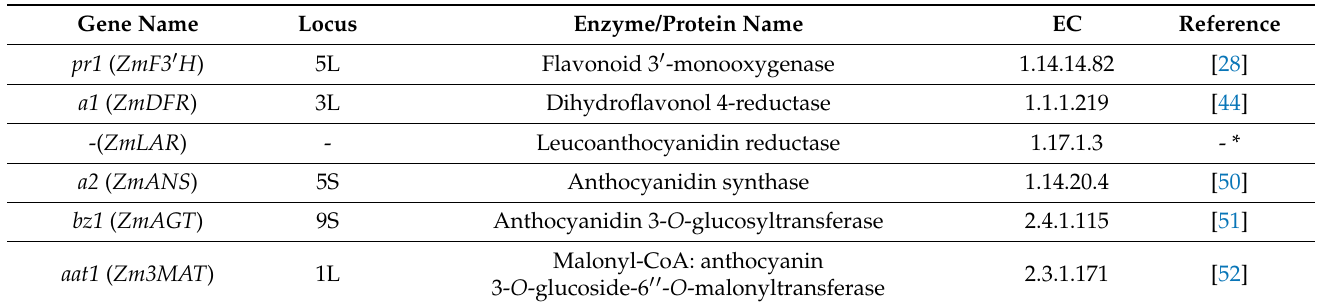
Table 2. Summary of anthocyanin genes in the maize flavonoid